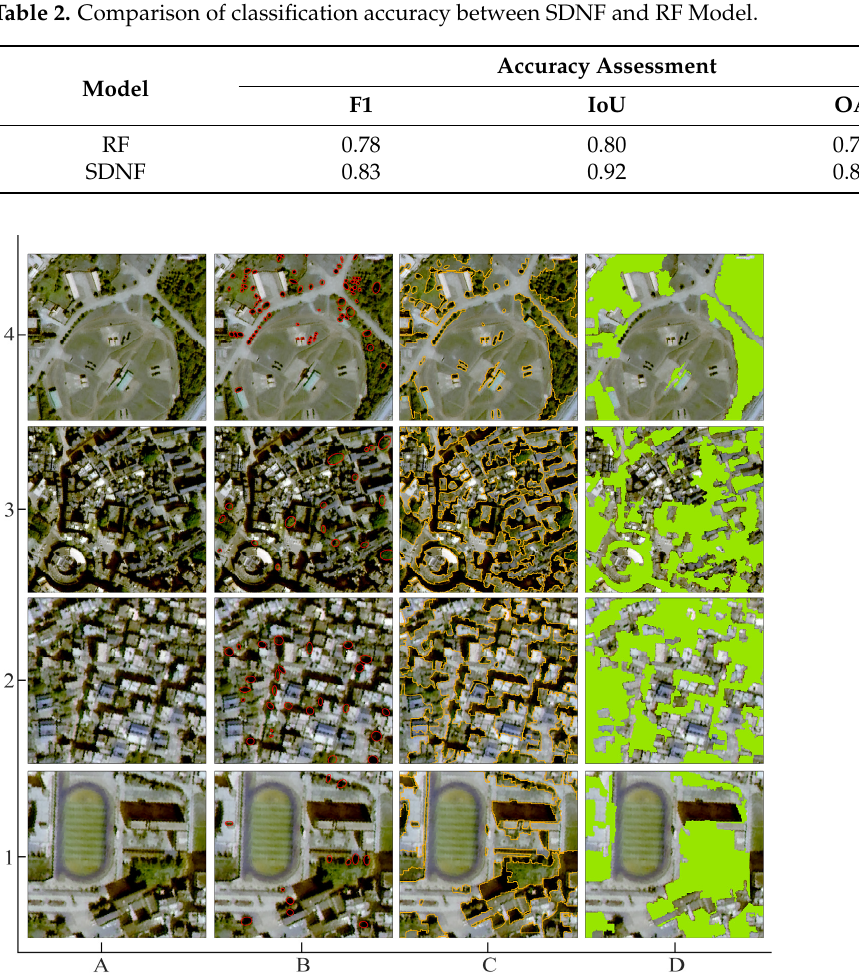
Figure 12. Detailed display of classification results of SDNF and RF methods. ( A ) The superpixel- enhanced images; ( B ) training sample images; ( C ) classification result based on SDNF; ( D ) classification result of RF.